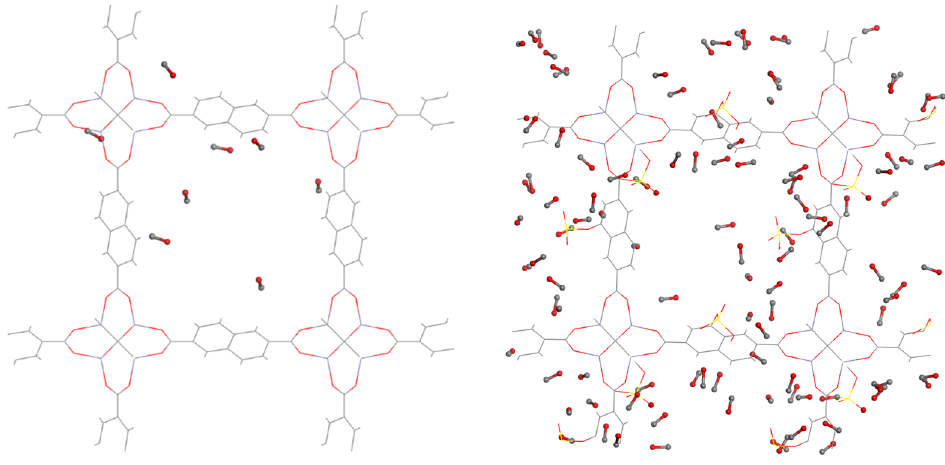
Figure 8. Snapshots for ( left ) IRMOF8 and ( right ) IRMOF8-OSO 3 H at T = 298 K, p = 0.60 bar.